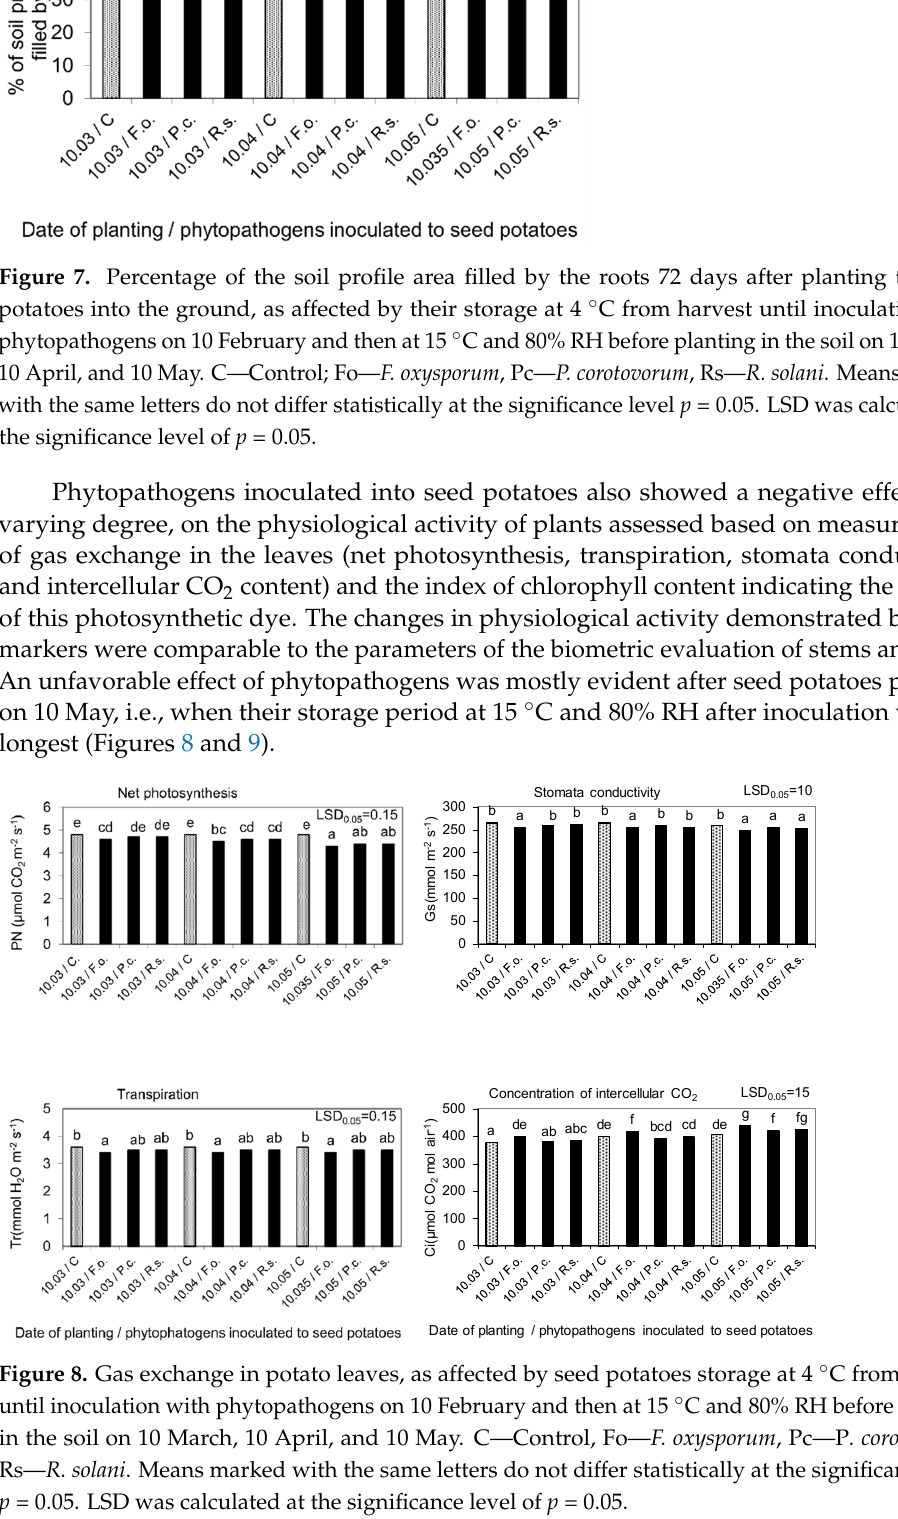
Figure 9. Index of chlorophyll content and first symptoms of their yellowing, as affected by seed potatoes storage at 4 °C from harvest until inoculation with phytopathogens on 10 February and then at 15 °C and 80% RH before planting in the soil on 10 March, 10 April, and 10 May. C—Control, Fo— F. oxysporum , Pc— P. corotovorum , Rs— R. solani . Means marked with the same letters do not differ statistically at the significance level p = 0.05. LSD was calculated at the significance level of p = 0.05. Table 4. Fresh and dry weight of tubers and dried stems per plant, obtained from the seed potatoes stored at 4 °C from harvest until inoculation with phytopathogens on 10 February and then at 15 °C and 80% RH before planting in the soil on 10 March, 10 April, and 10 May. Date of Seed Potatoes Plant- ing to Soil Phytopathogens Inoculated to Seed Potatoes